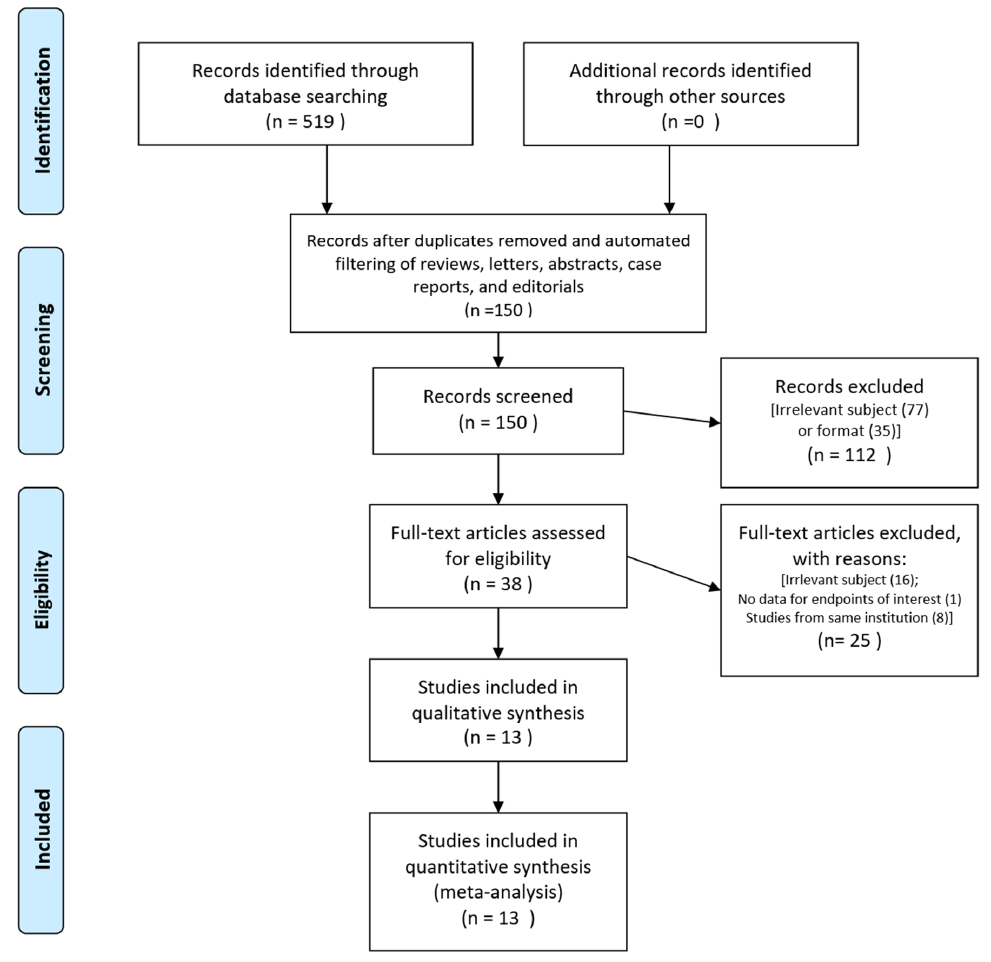
Figure 1. Flowchart of the study selection process.